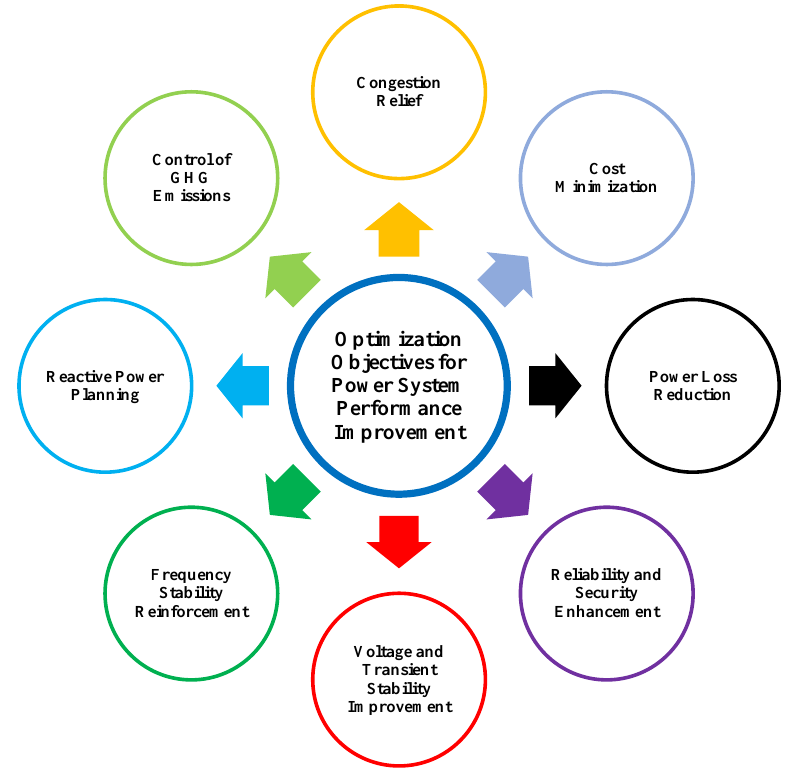
Figure 3. Various optimization objectives for power system performance